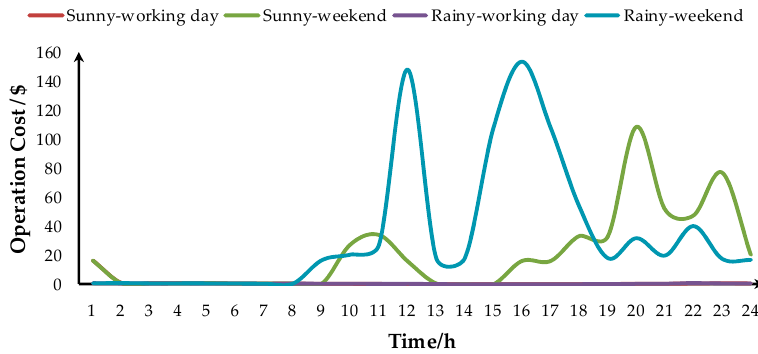
Figure 10. Operation cost of each period in four scenarios.